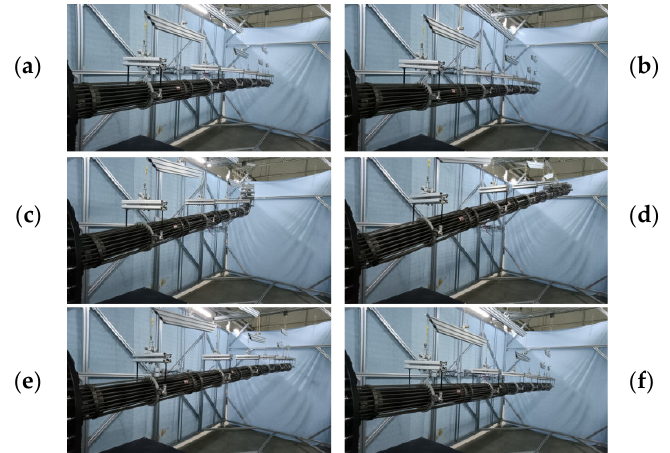
Figure 19. Physical image of the movement process of the HRM. ( a ) First scenario; ( b ) Second scenario; ( c ) Third scenario; ( d ) Fourth scenario; ( e ) Fifth scenario; ( f ) Sixth scenario.